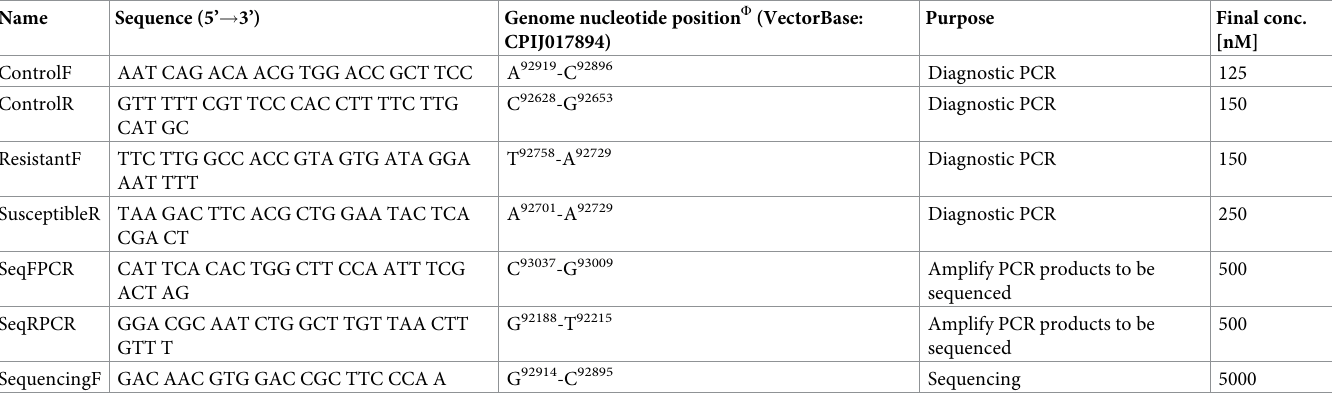
Table 1. Primers for kdr -like diagnostic PCR and Na v gene fragments amplification and